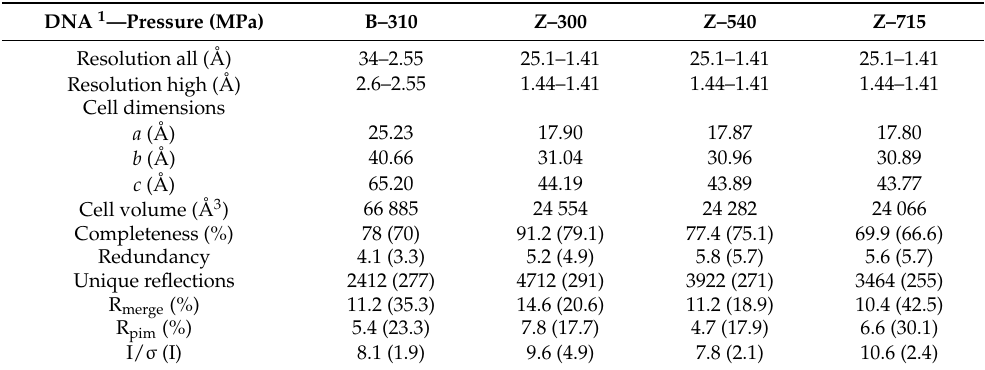
Table 1. Summary of data collection and processing statistics (space group P 2 1 2 1 2 1 , Z = 4 for all). Values in parentheses are for the highest resolution shell.